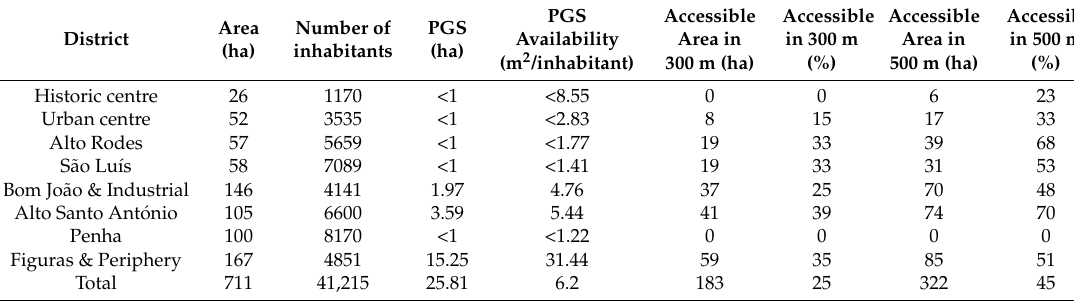
Table 5. Availability and accessibility of public green spaces (PGS) in